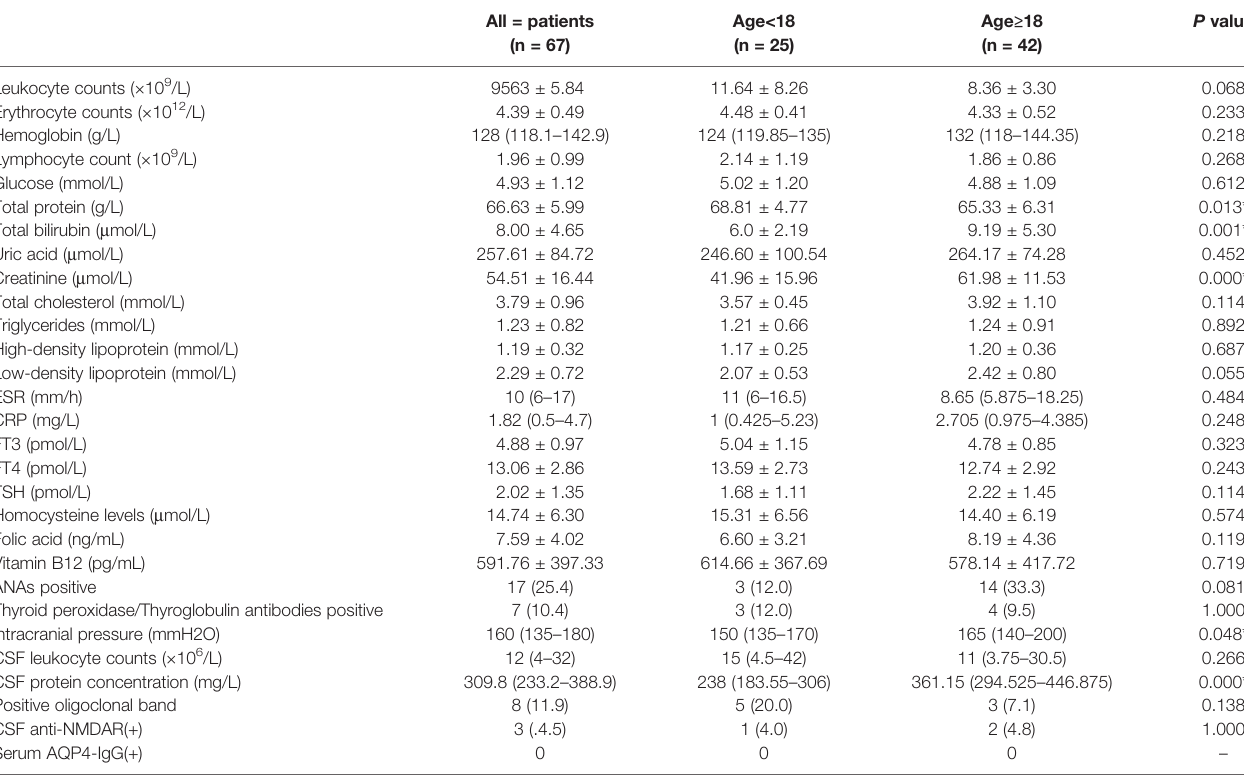
TABLE 3 | Laboratory data.